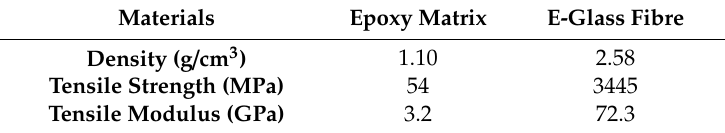
Table 1. Di ff erent impact energies applied to the EP, EP-BF composites and EP / G-BF composites. Materials